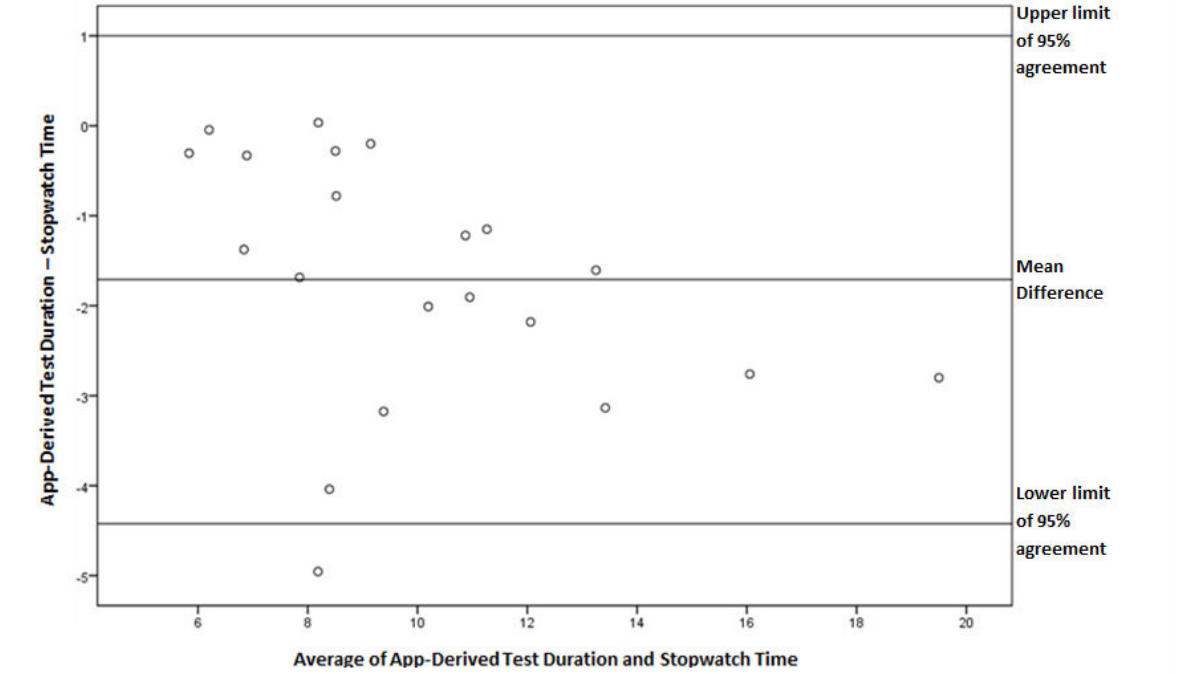
Figure 8. A Bland-Altman plot of differences between app-derived test duration and stopwatch time during the Stair Climb Test. Line of mean difference is at -1.71 and upper and lower limits of 95% agreement are at 1.00 and -4.42,